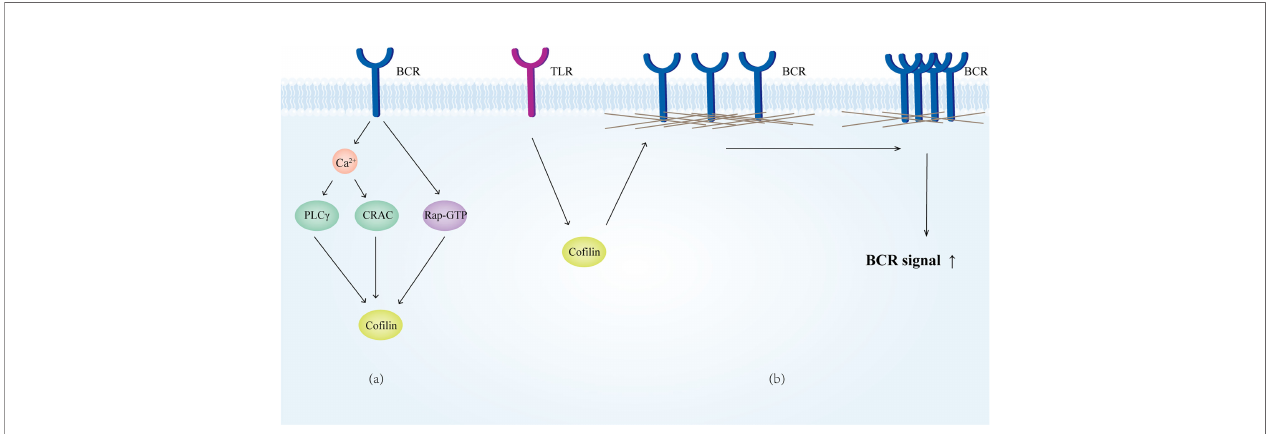
FIGURE 8 | Co fi lin in B cells. (A) Co fi lin receives signals from the BCR. (B) Co fi lin mediates the depolymerization of micro fi laments on the membrane surface upon receiving TLR signaling, which increases BCR motility and facilitates the BCR